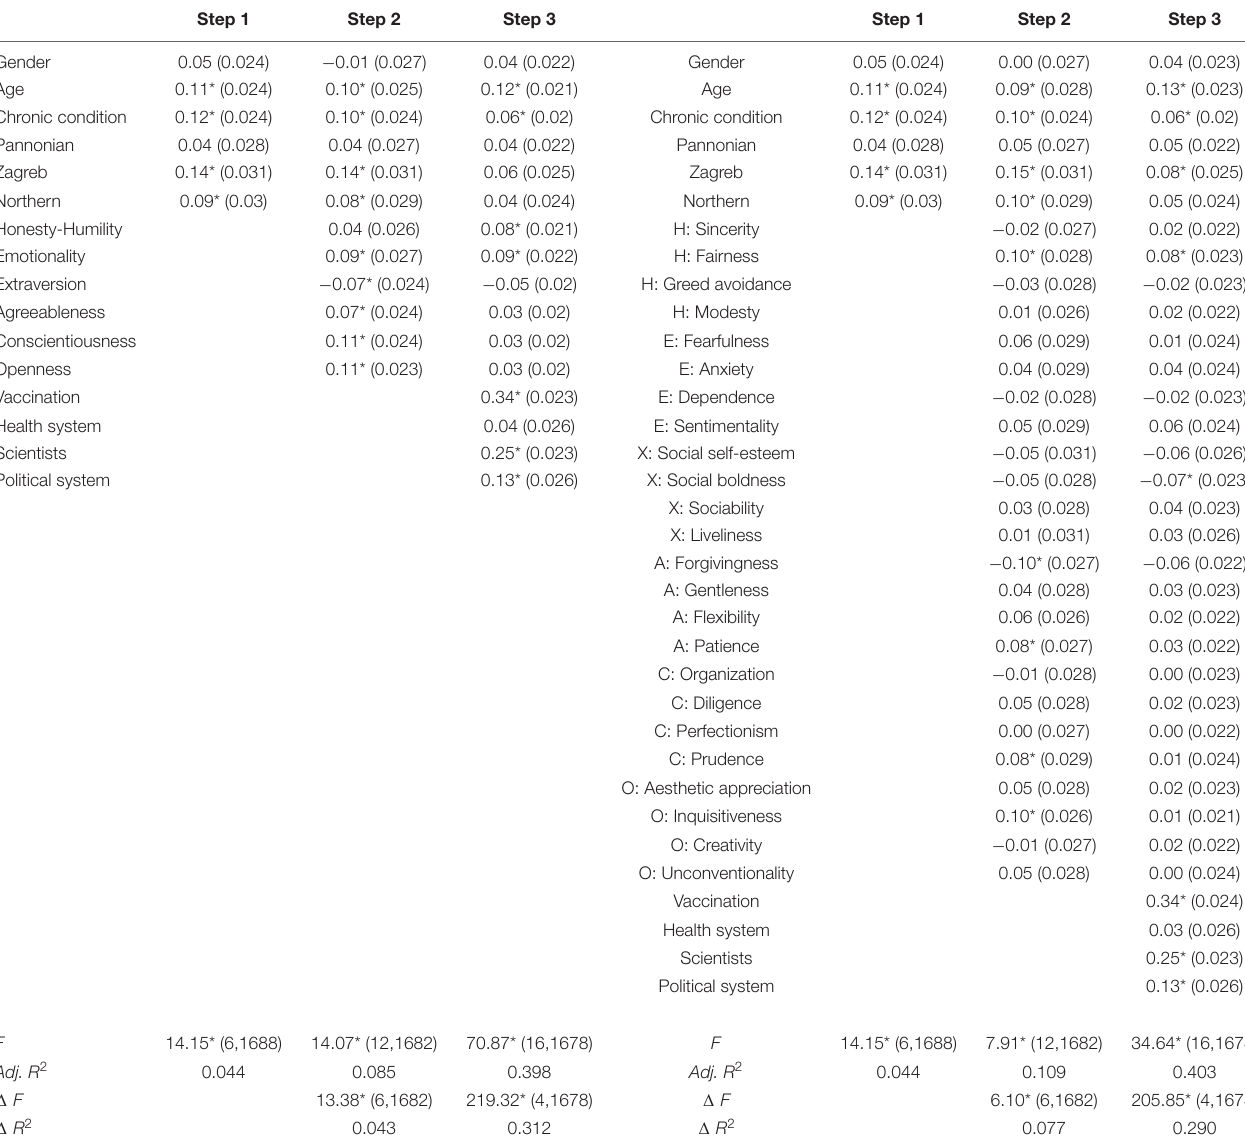
TABLE 3 | Summary of hierarchical regression analyses with standardized regression coefficients and SEs in